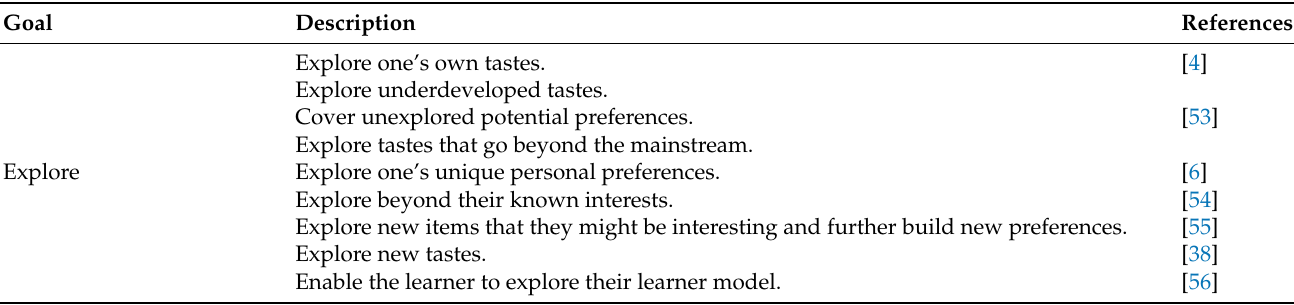
Table 1. Potential self-actualization